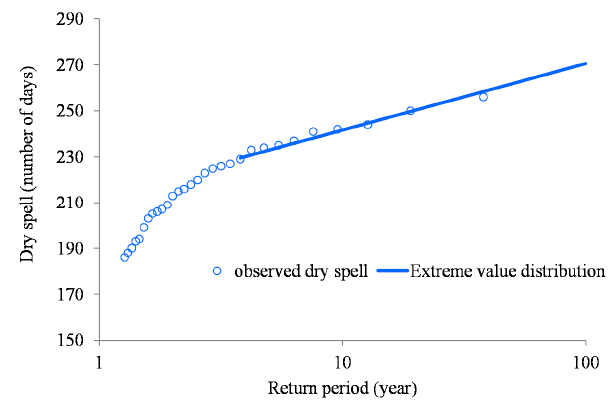
Figure 3. Theoretical distribution fitted to hydrological dry spell of 15-day aggregation level in flow observed from 1965 to 2002 at Khartoum. The horizontal axis is based on logarithmic scale.